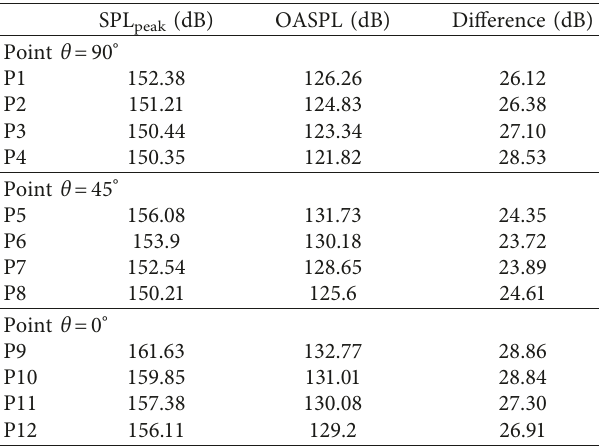
Table 1: Average measured SPL peak and OASPL of impulse noise.